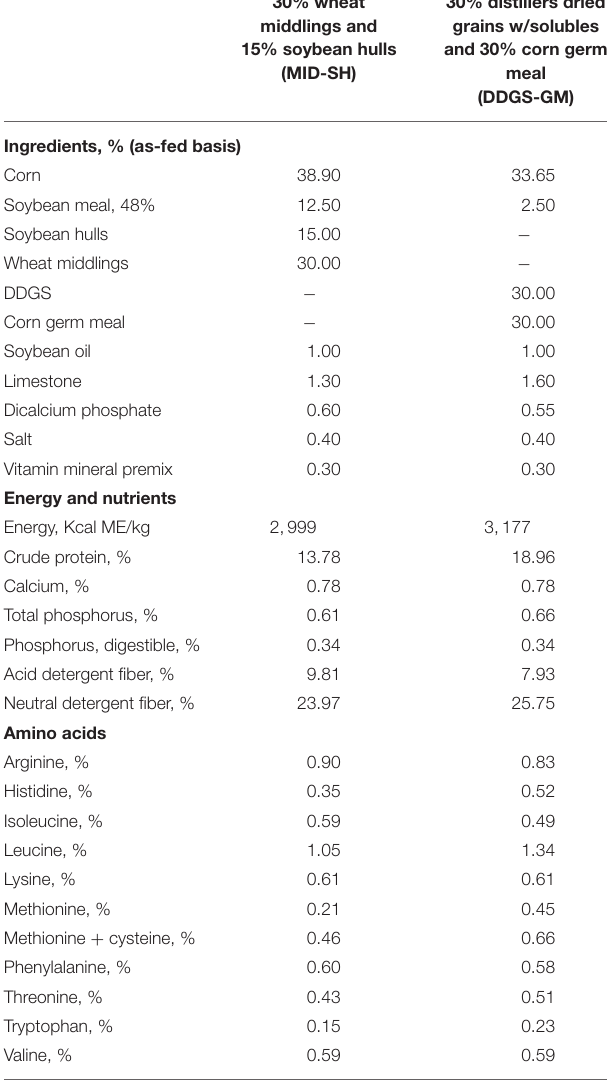
TABLE 1 | Composition of the experimental diets fed to group-housed sows during gestation a